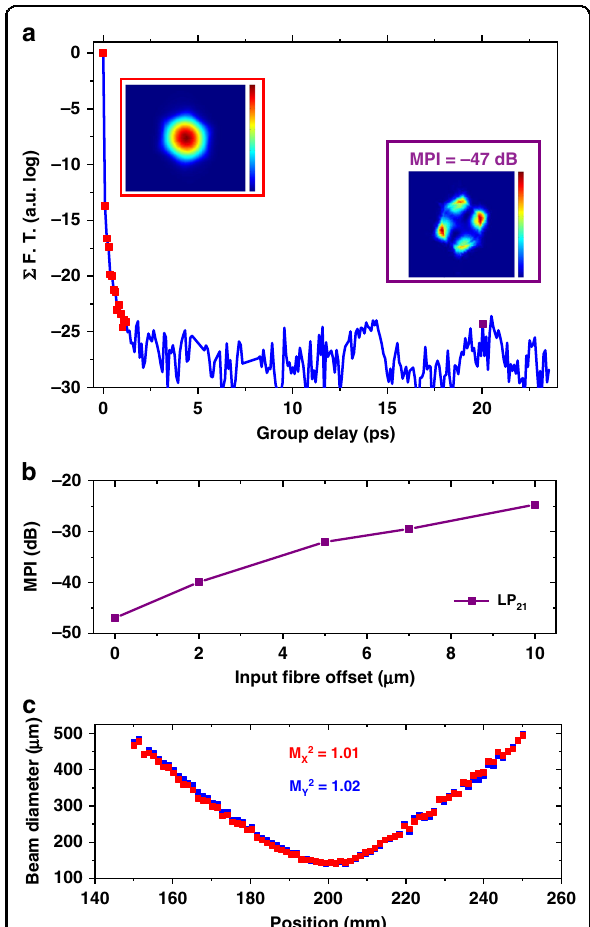
Fig. 6 HKT-HCPCF modal content characterisation. a S 2 measurement results for a 10 m long fi bre. b MPI as a function of the input fi bre offset. c M 2 measurement